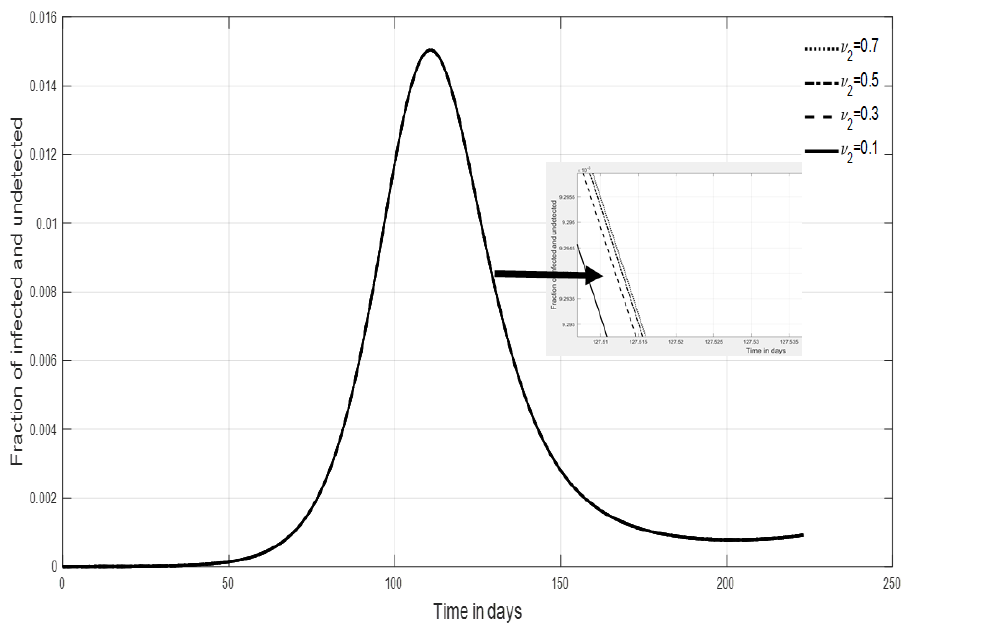
Figure 5. Shows the effects of varying ν 2 on the fraction of infectious undetected cases.